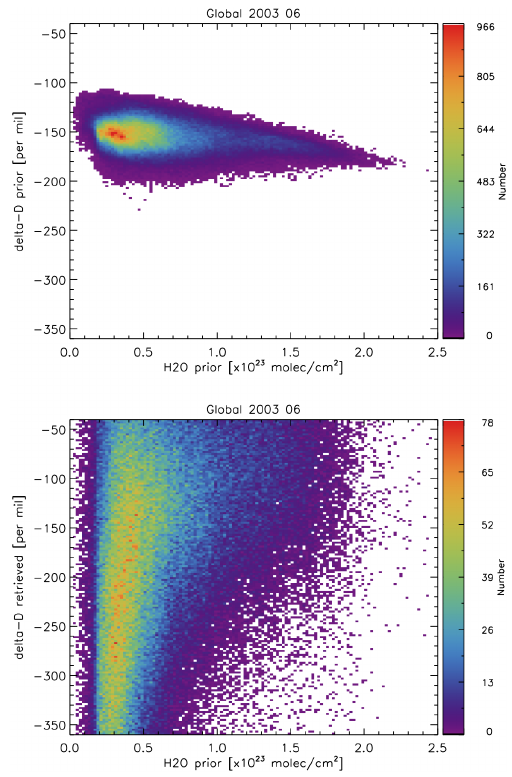
Figure 2. Top: density distribution of the a priori column-averaged δD based on variable H 2 O profiles and a fixed HDO depletion pro- file. Bottom: density distribution of the a posteriori δD derived from the retrieval of total column H 2 O and HDO. The colour scale in both panels corresponds to the number of measurements in every box, and for both panels all measurements in June 2003 were